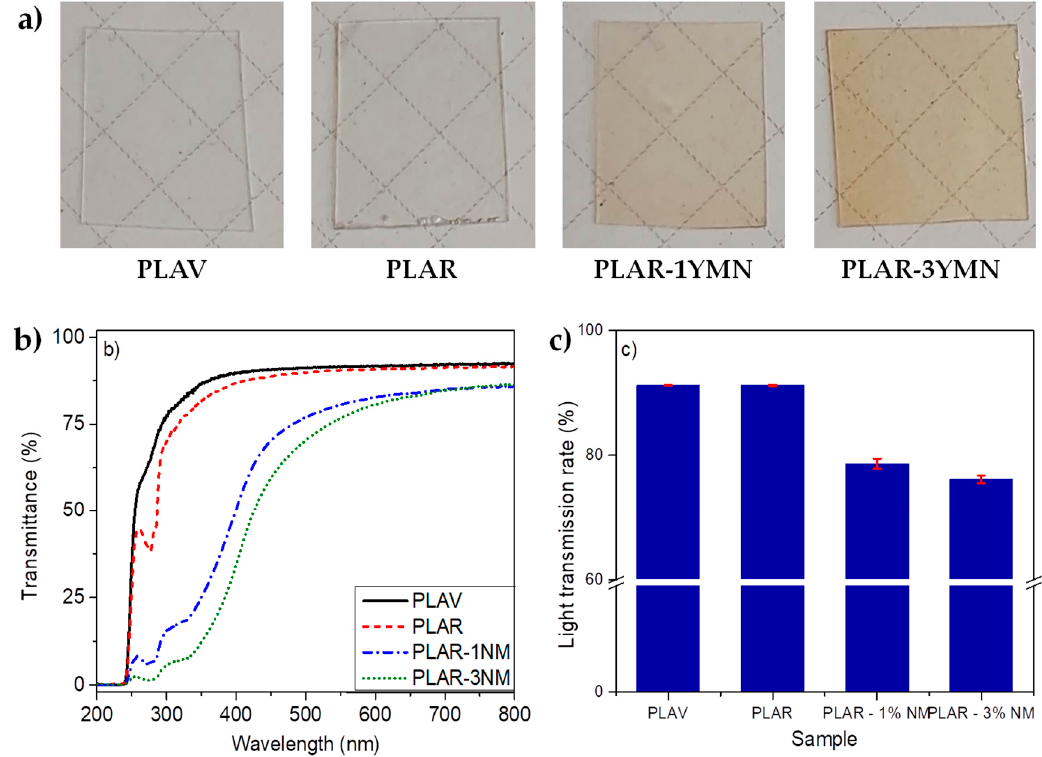
Figure 9. PLAV, PLAR and bionanocomposites (PLAR-1YMN and PLAR-3YMN): ( a ) visual appearance, ( b ) UV-vis spectra and ( c ) visible light transmission rates.